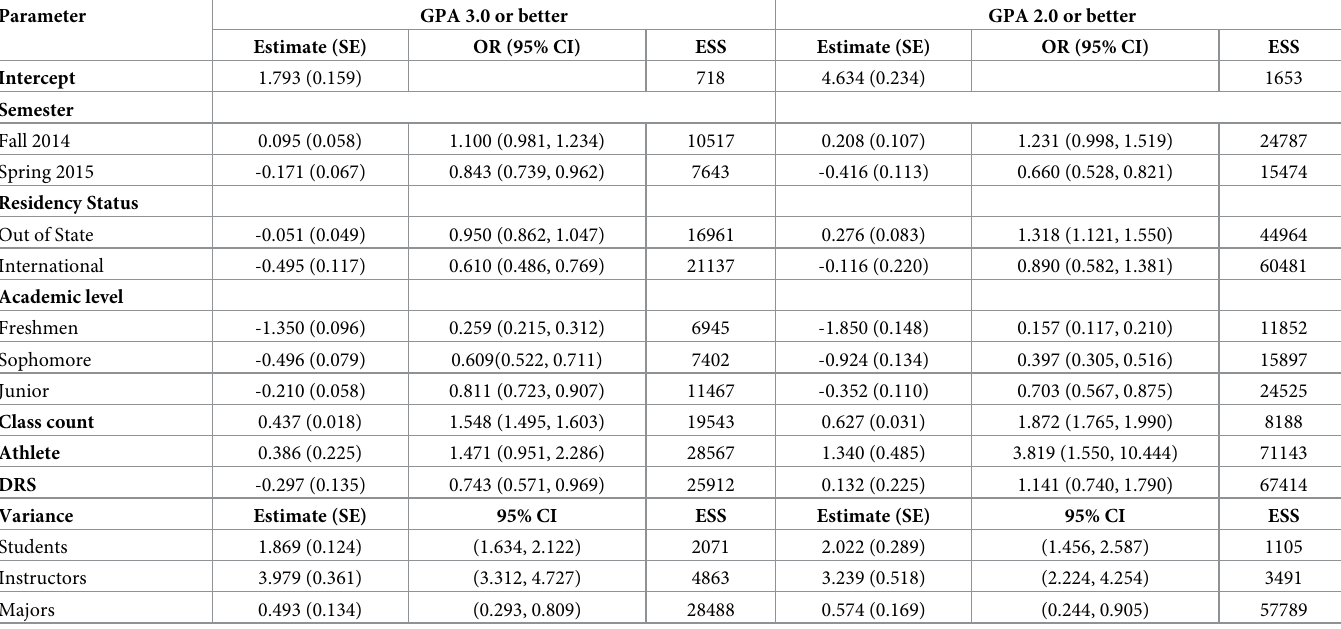
Table 3. Modeling GPA 3.0 or better/ GPA 2.0 or better.